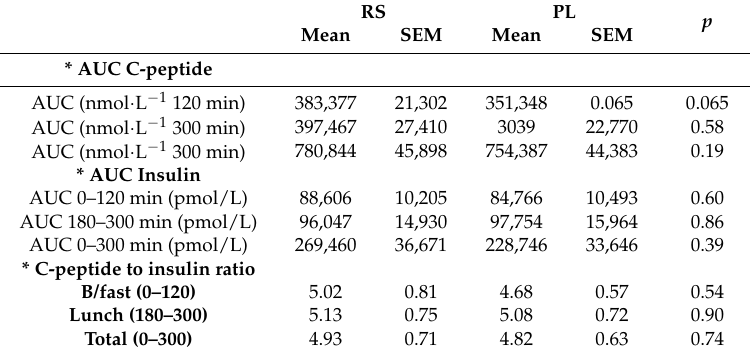
Figure 3. Postprandial plasma C-peptide concentrations after the consumption of 48 g of resistant starch (RS) or placebo (PL). The values represent means ± SEM ( n = 10). Comparisons were made using repeated measures ANOVA. Table 4. AUC plasma C-Peptide response, AUC plasma insulin response and C-peptide to insulin ratio for breakfast (0–120 min), lunch (180–300 min) and the total (0–300 min) after the consumption of RS or PL ( n = 10). Comparisons made by paired sample t -test and were not significantly different.